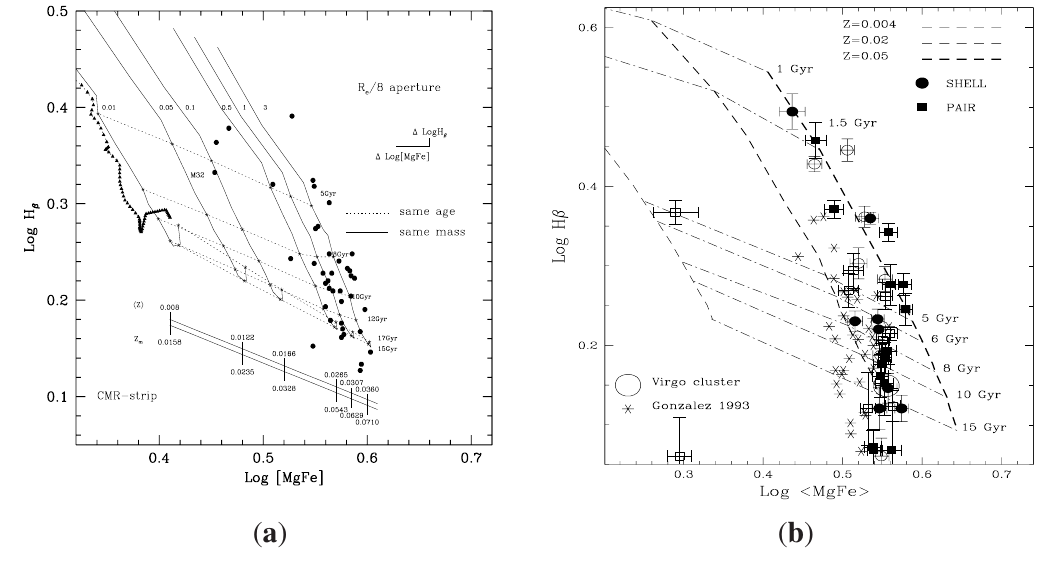
Figure 3. ( a ) The H versus [MgFe] plane for the galaxies (full dots) of [12] and the β models (solid lines) of ETGs of [40]. Each model is labelled by its baryonic mass M in units of 10 12 M . The dotted lines are isochrones of different age (in Gyr) as indicated. ⊙ The line called CMR-strip with the mean and maximum metallicities of the galactic models annotated along it is the analog of the CMR. The solid triangles show the evolutionary path of the 3 model galaxy of [2] calculated with the closed-box formalism. The full 10 12 M × ⊙ dots and their mean error bars are the Re/8 data of [12]. Finally, the vectors ∆ log H ∆ log[ MgF e ] display the mean shift in the data going from the R/8 data to the Re/2 data. To our knowledge this is the only case in literature where instead of SSPs, galaxy models are used; ( b ) the same as in the left panel but for the galaxies (asterisks) by [12] and the sample of shell (full circles) and pair (full squares) galaxies by [74], and SSPs from [42] of different metallicity. The dotted dashed lines are isochrones of different age. Normal and dynamically interacting galaxies have the same distribution. ( a ) is reproduced with permission from